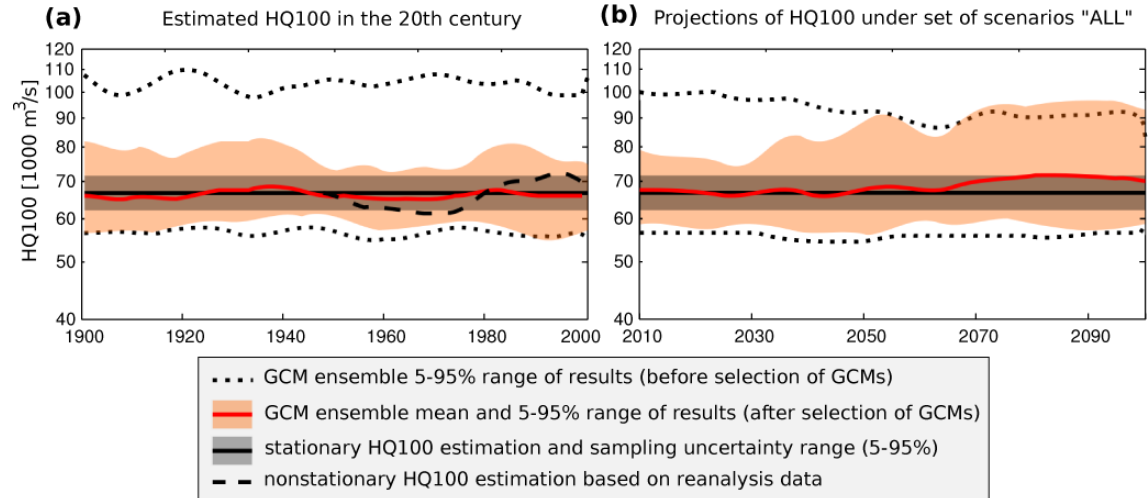
Figure 3. HQ 100 in Kratie obtained by fitting a statistical model to the results of the ensemble of GCMs. The ensemble mean is drawn in red with its 5th and 95th percentile. The black dashed line is the application of the non-stationary model to the monsoon index based on the reanalysis data. In addition, HQ 100 estimated by the stationary model M 0 on the basis of the observed flood peaks, including the 90% sampling uncertainty, is shown (black solid line). (a) shows results based on measured and reanalysis data, together with GCM results under the baseline scenario 20C; (b) shows GCM results for the set of all scenarios considered ALL.